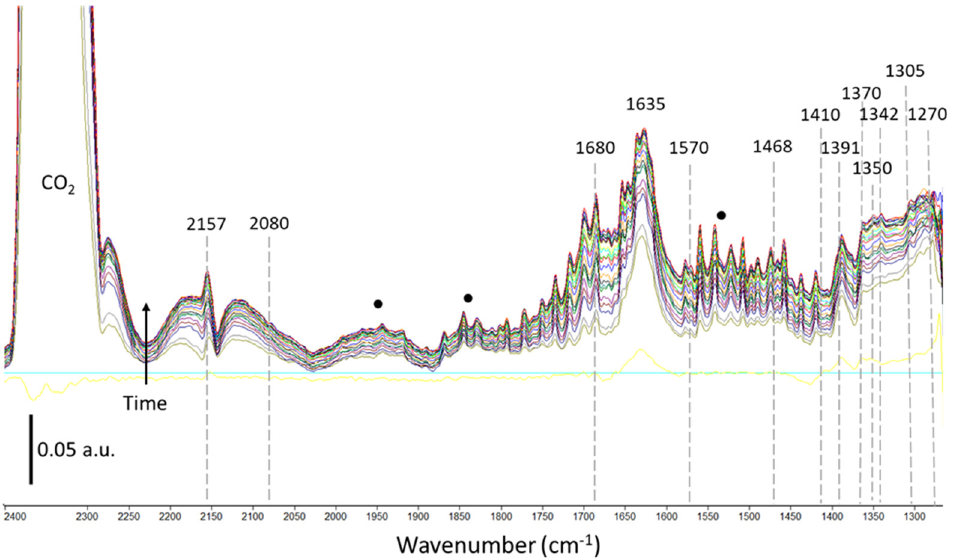
Figure 7. FTIR subtraction spectra acquired as a function of time up to steady state after plasma ignition in CO 2 methanation conditions on 3Ru/CsUSY, in the 2400–1250 cm − 1 region. (Black dots indicate bands assigned to USY zeolite).